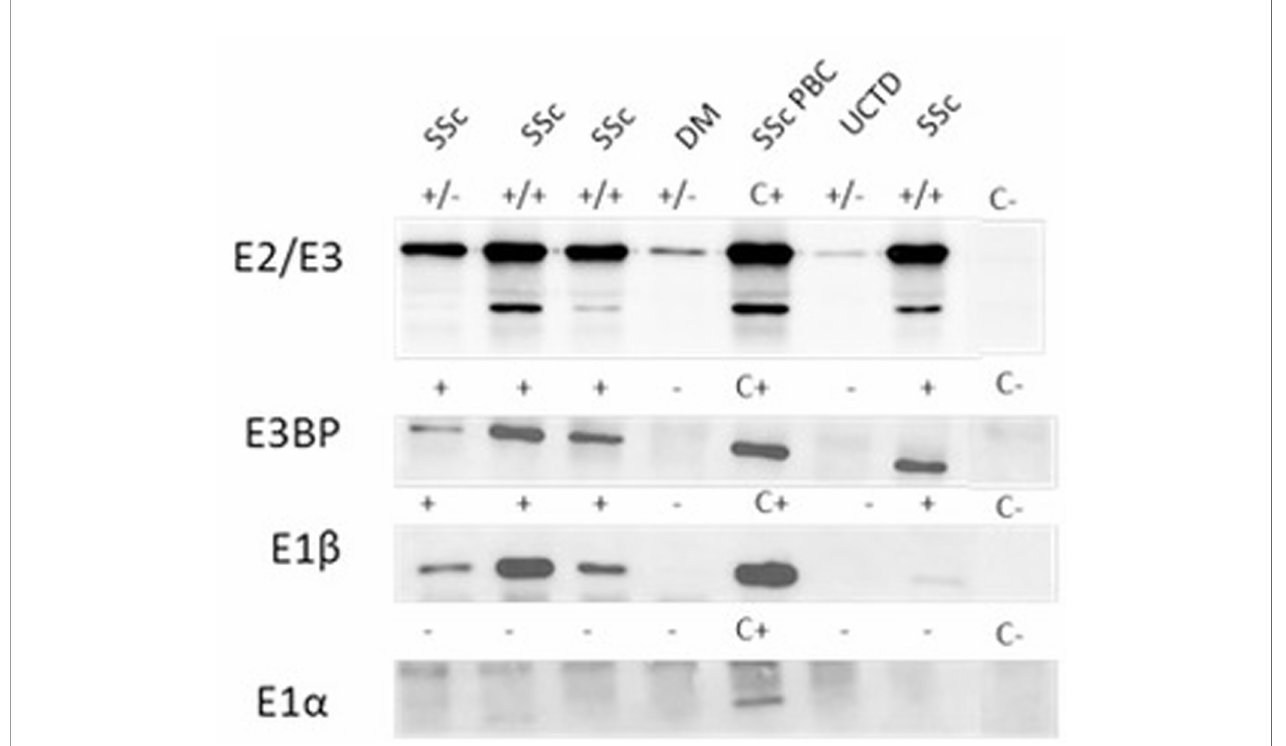
FIGURE 2 | Autoantibody reactivity to PDC antigens by IP-WB. Different reactivities directed against the PDC subunits (E2/E3, E3BP, E1 b , E1 a ) in AMA-positive representative sera from patients with SSc with and without PBC, one patient with DM and one with UCTD. C+, positive control; C-, negative control; +/- refers to the positivity of only one of the two components of the E2/E3 complex; +/+ both components of the E2/E3 complex are positive; - negative IP-WB band. AMA, antimitochondrial antibodies; DM, dermatomyositis; IP-WB, immunoprecipitation-Western Blot; PBC, primary biliary cholangitis; PDC, pyruvate dehydrogenase complex; SSc, scleroderma, systemic sclerosis; UCTD, undifferentiated connective tissue